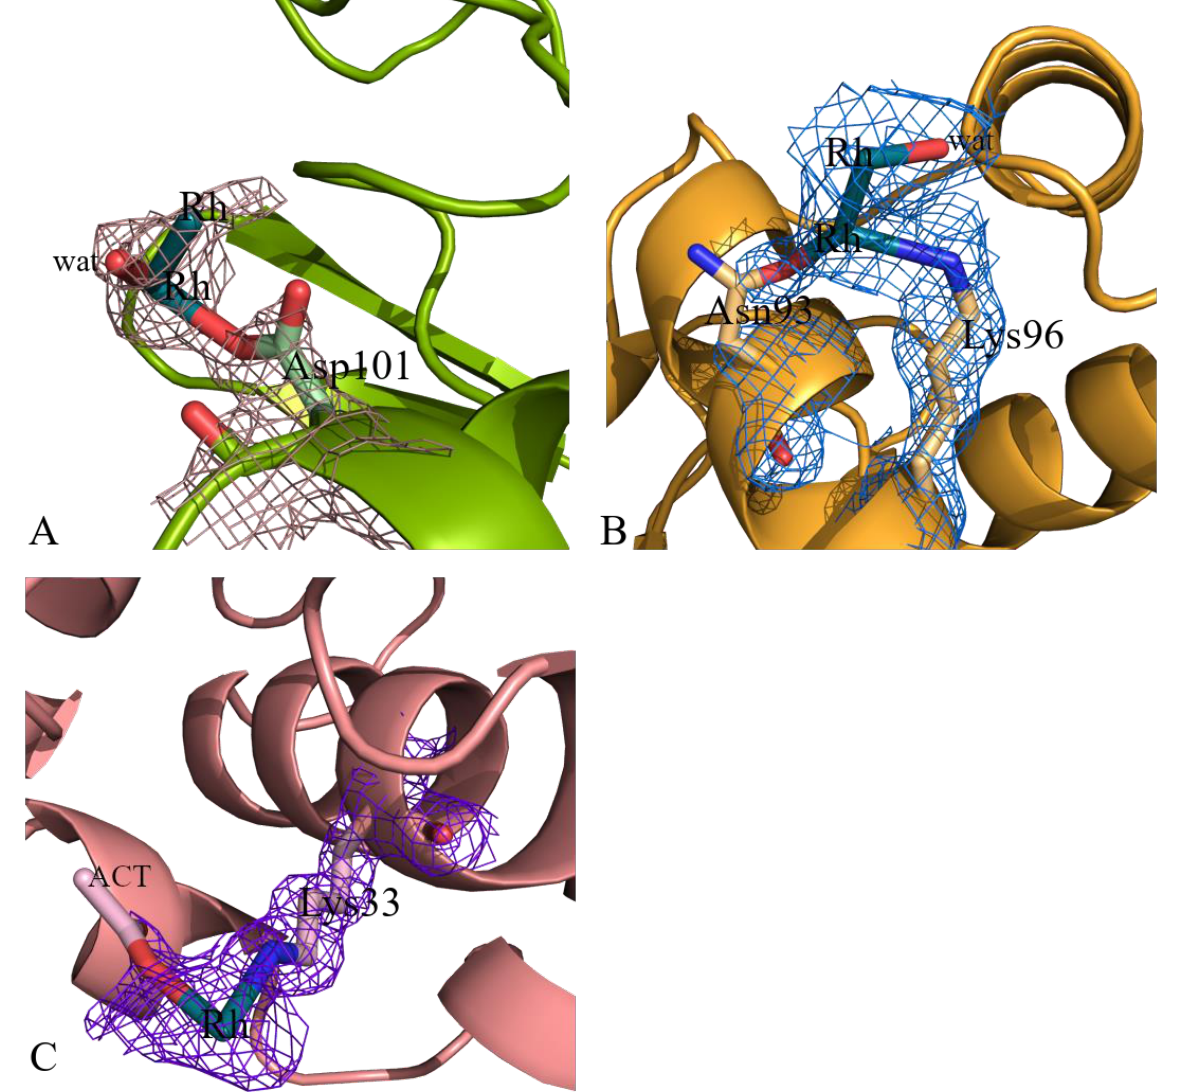
Figure 8. Details of the Rh binding sites close to side chains of Asp101 ( A ), Asn93 and Lys96 ( B ) and Lys33 ( C ) in Crystal 6. 2Fo-Fc electron density maps are contoured at 1.0 σ.